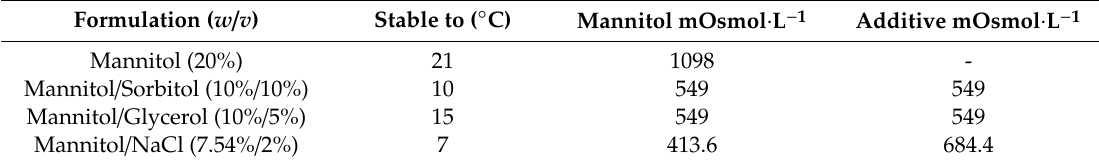
Table 1. Formulation approaches to achieve the target of 1098 mOsmol · L − 1